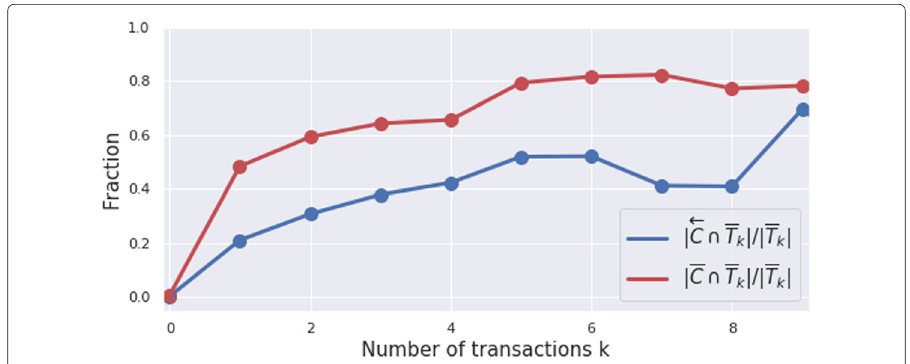
Fig. 9 Fraction of member pairs linked by k transactions that are also linked by a certification. The blue plot